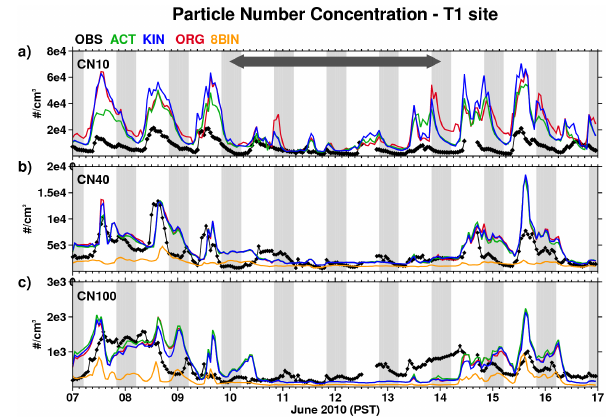
Figure 2. Same as Fig. 1, except for the T1